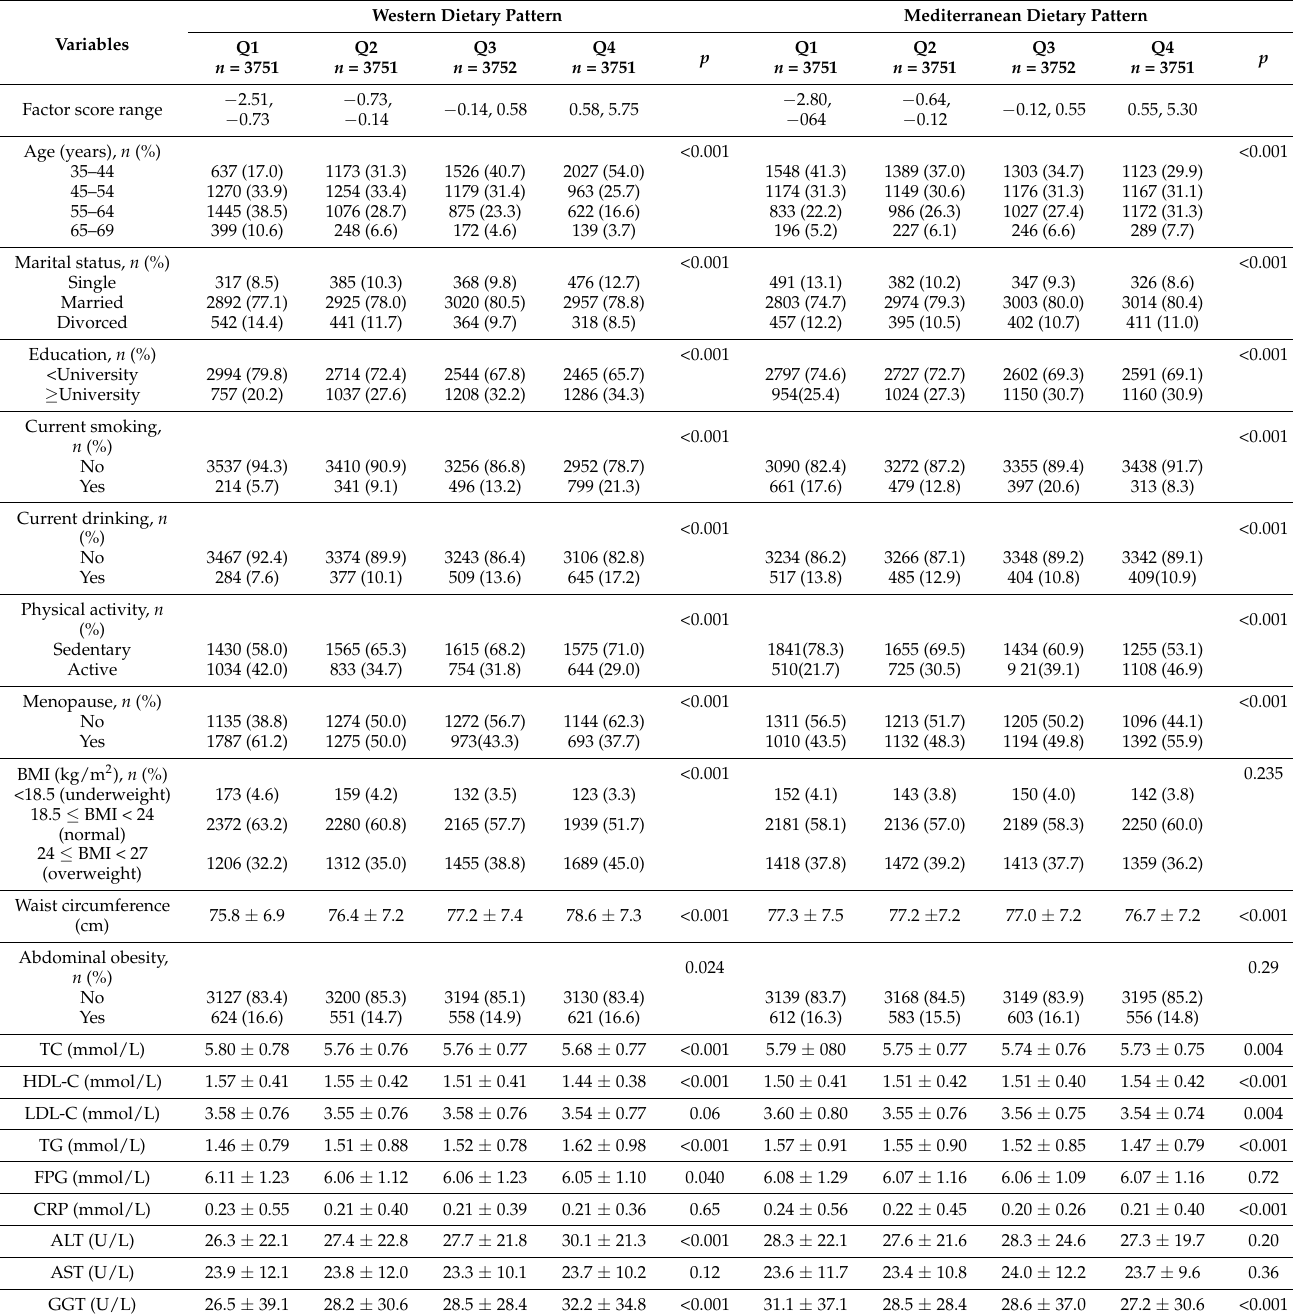
Table 3. Characteristics of subjects across quartiles of major dietary patterns ( n = 15,005) 1